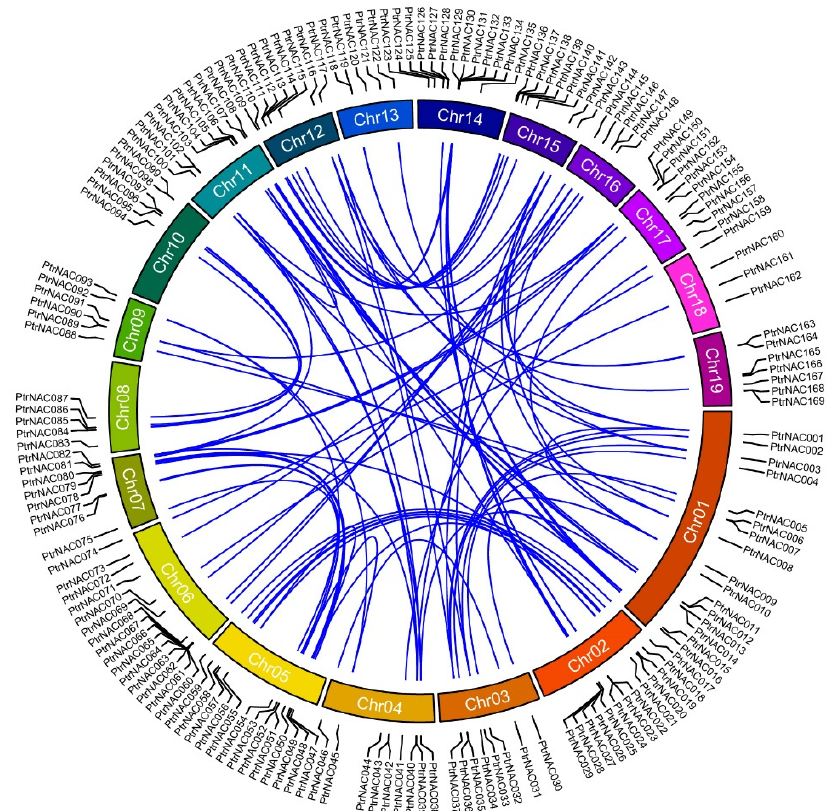
Figure 1. Distribution of NAC genes on the poplar genome. The blue lines inside the circle represented PtrNAC duplicated gene pairs, rectangles indicated chromosomes of poplar, and the gray lines denoted all poplar duplicated gene pairs.